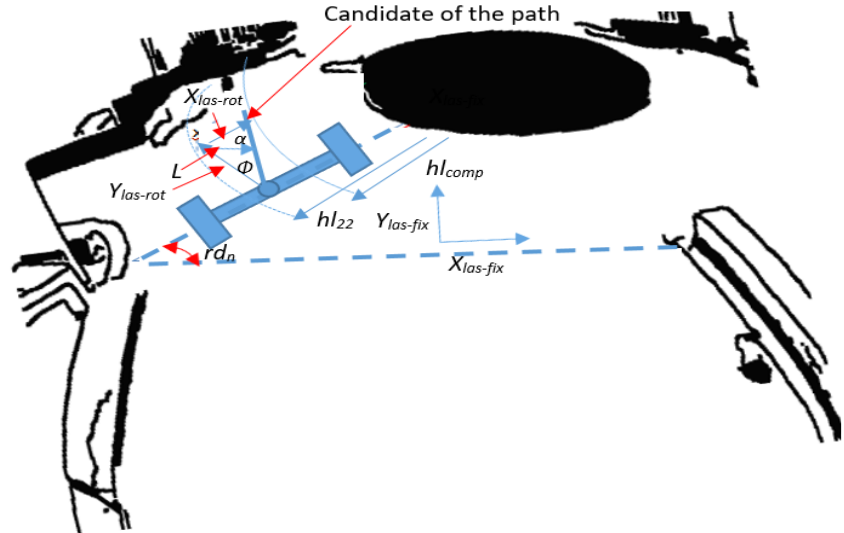
Figure 14. Roundabout center parameters and path determination.